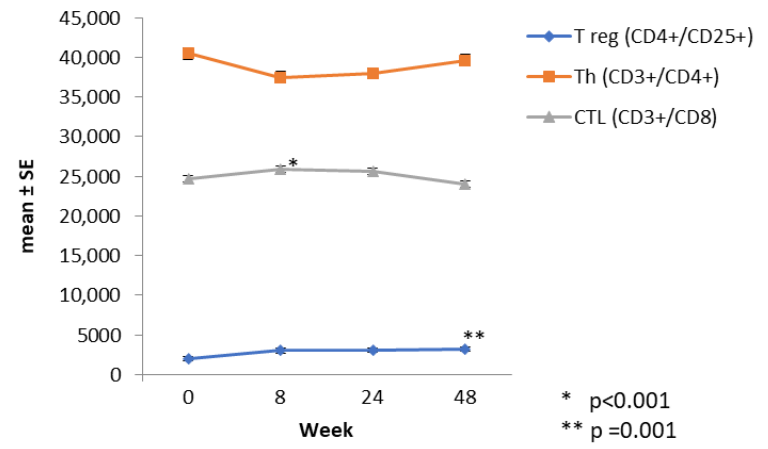
Figure 2. Trends in T lymphocyte subpopulations in 33 patients at specific times after starting